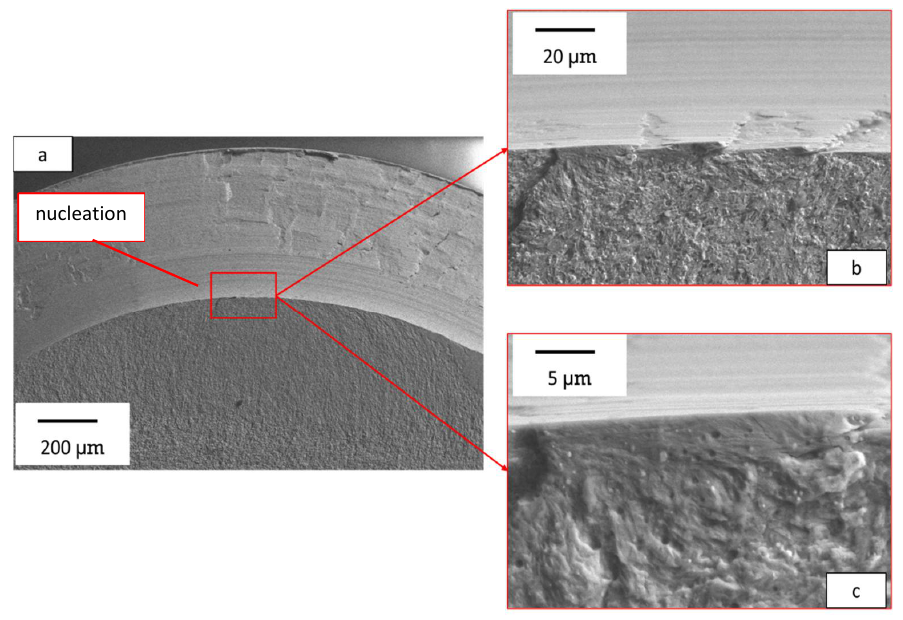
Figure 16. SEM-SE low magnification fractography of a notched sample ( a ) and high magnification of the crack nucleation site in correspondence of machining flaws of the notch root ( b , c ). The morphologies of the fracture surfaces in the propagation and failure zones, how- ever, are comparable to the corresponding areas of the unnotched specimens (Figure 17).